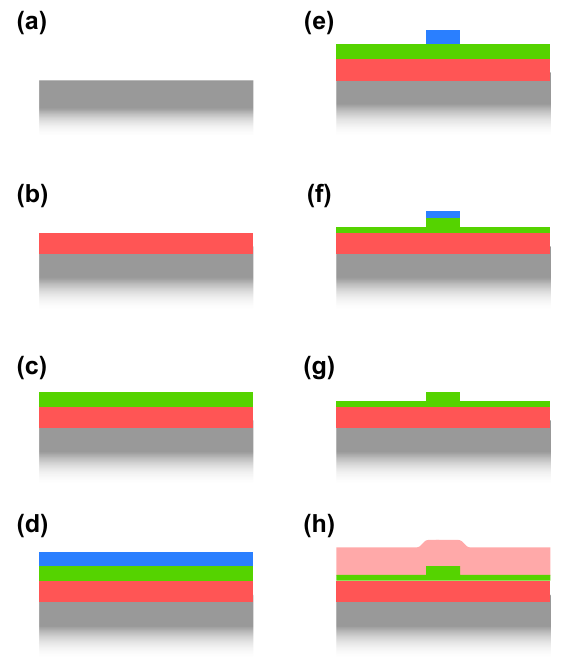
Figure 7: Generic fabrication process for nanophotonic waveguides. (a) The carrier wafer (grey), typically silicon. (b) Deposition of the bottom cladding (red) and (c) deposition of the waveguide layer (green). (d) And (e) lithography using a photoresist (blue). (f) Etching of the waveguide via the patterned photoresist mask. Here the waveguide is only partially etched. (g) Resist stripping and cleaning. (h) Top cladding deposition (light